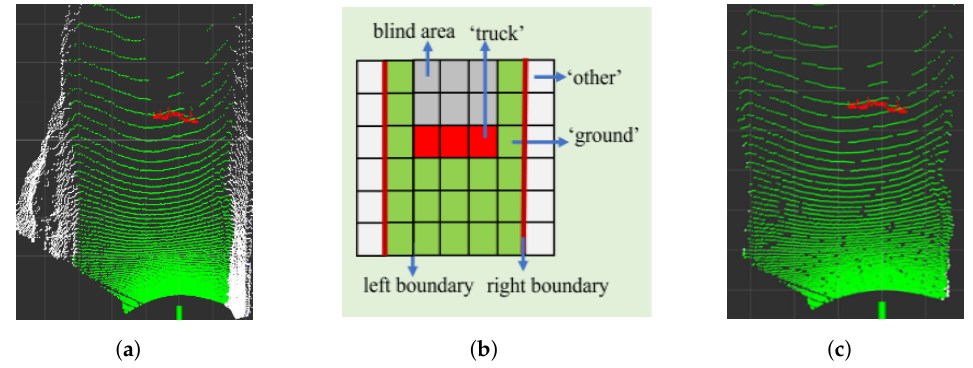
Figure 5. Pipeline for road region searching. ( a ) Semantic segment point clouds. ( b ) Grid map searching. ( c ) ROI point